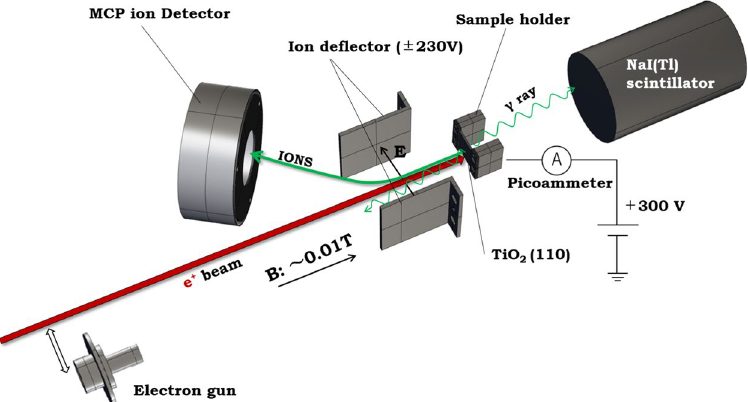
Figure 4. Schematic diagram of the TOF measurement system for desorbed ions. A positron beam was transported by an axial magnetic field (0.01 T) and was incident normal to the sample surface. The TiO 2 sample was biased at a voltage of 300 V. Annihilation γ rays emitted from the target were detected by a NaI(Tl) scintillator coupled with a photomultiplier tube. The positive ions desorbed from the target were accelerated by the target bias of 300 V and were directed to an ion deflector with a potential difference of 460 V. The ionic trajectories in the deflector were deflected and directed to a MCP ion detector. The e + SD-TOF spectrum was obtained through analysis of the time interval between the signals from the NaI(Tl) scintillator and the MCP. An electron gun was mounted on a linear manipulator to move it into and out of the beam path, allowing measurement of the ESD-TOF